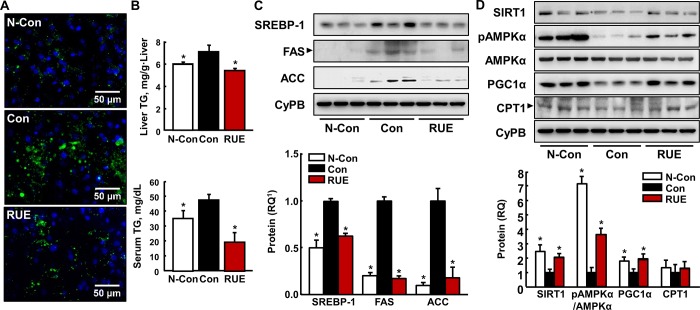
RUE attenuates alcohol-induced hepatic steatosis.(A) Representative images of boron-dipyrromethene (BODIPY) staining of lipid droplets in the liver tissue (200× magnification); (B) Levels of triglyceride (TG) accumulation in serum and liver tissue. All data are presented as the mean ± SEM. (*P < 0.05 vs. control); (C) Immunoblot analyses of lipogenic genes (SREBP-1, ACC, and FAS) in liver tissue with the loading control CyPB. All data are presented as the mean ± SEM. (*P < 0.05 vs. control); (D) Immunoblot analyses of fatty acid oxidative genes (SIRT1, AMPK-α, PGC1-α, and CPT1) with the loading control CyPB. All data are presented as the mean ± SEM. (*P < 0.05 vs. control) 1RQ, relative quantity.